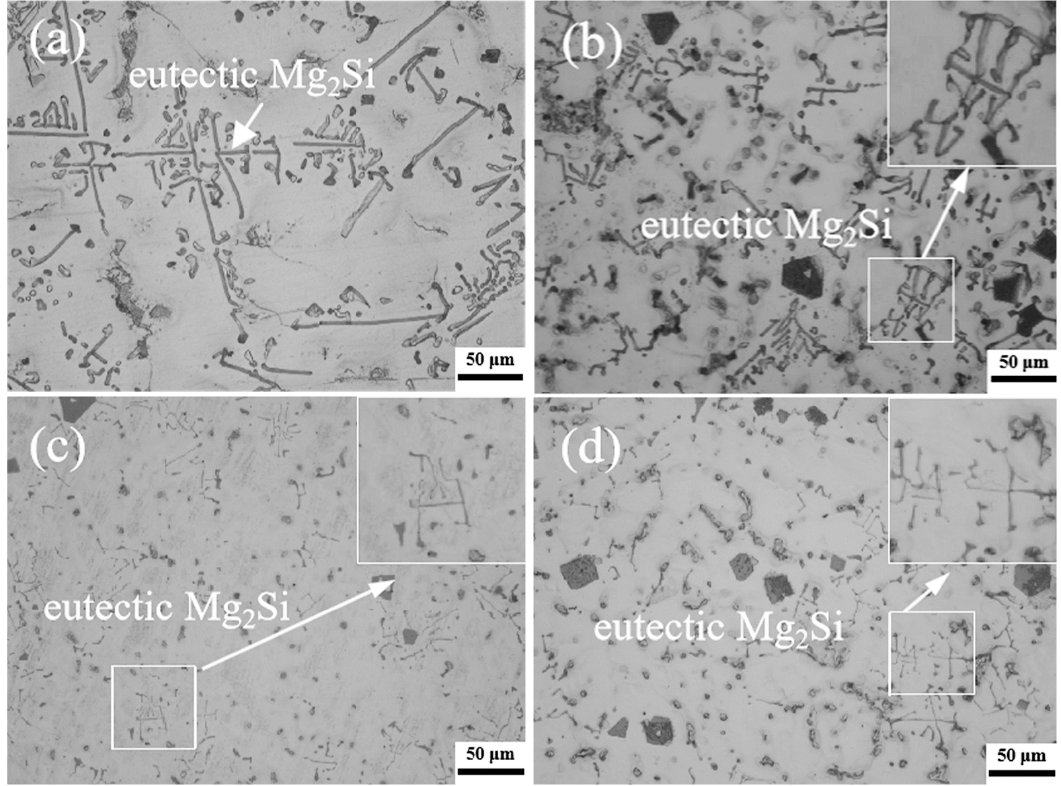
Figure 5. The morphologies of eutectic Mg 2 Si in the alloy and the composites ( a ) M-AC, ( b ) 1-COM, ( c ) 3-COM, and ( d ) 5-COM. (Scale bar = 50 μ m).